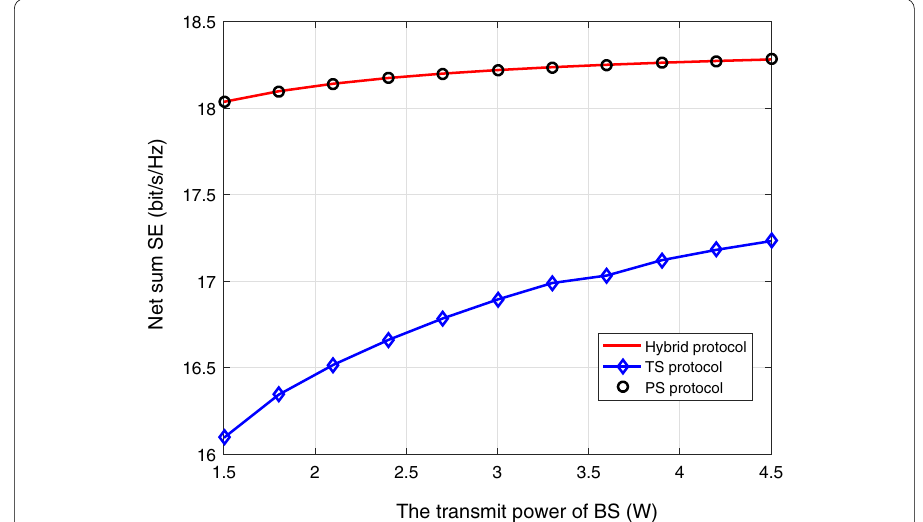
Fig. 6 Net sum spectral efficiency versus the transmit power of base station